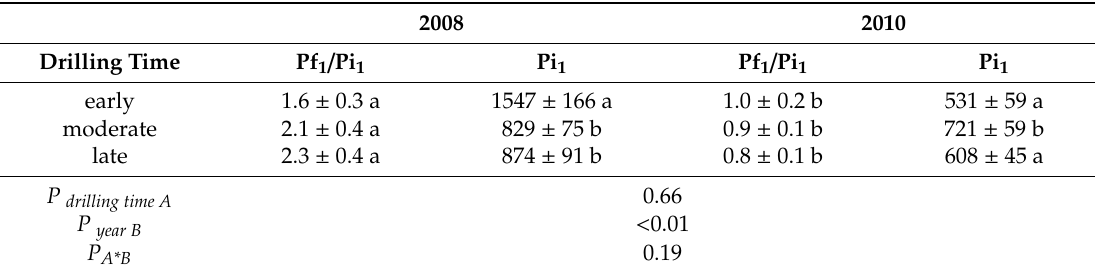
Table 2. Mean multiplication rates (Pf1 / Pi1) and initial population densities Pi1 of beet cyst nematode (BCN) under winter oil seed rape (OSR) at di ff erent sowing